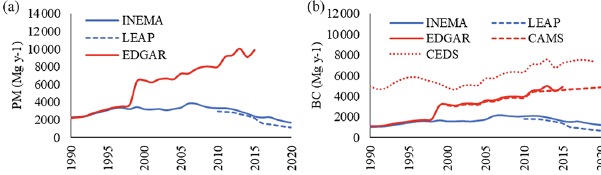
Figure 8. Comparison between CO 2 (a) and CH 4 (b) between this work (INEMA) and other local and global emission inventories.